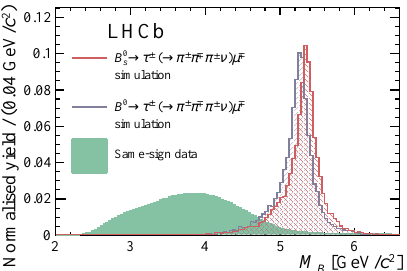
Figure 5: Normalized distributions of the reconstructed invariant mass for B 0 and B 0 in simulated event samples and for same-sign s candidates in data.